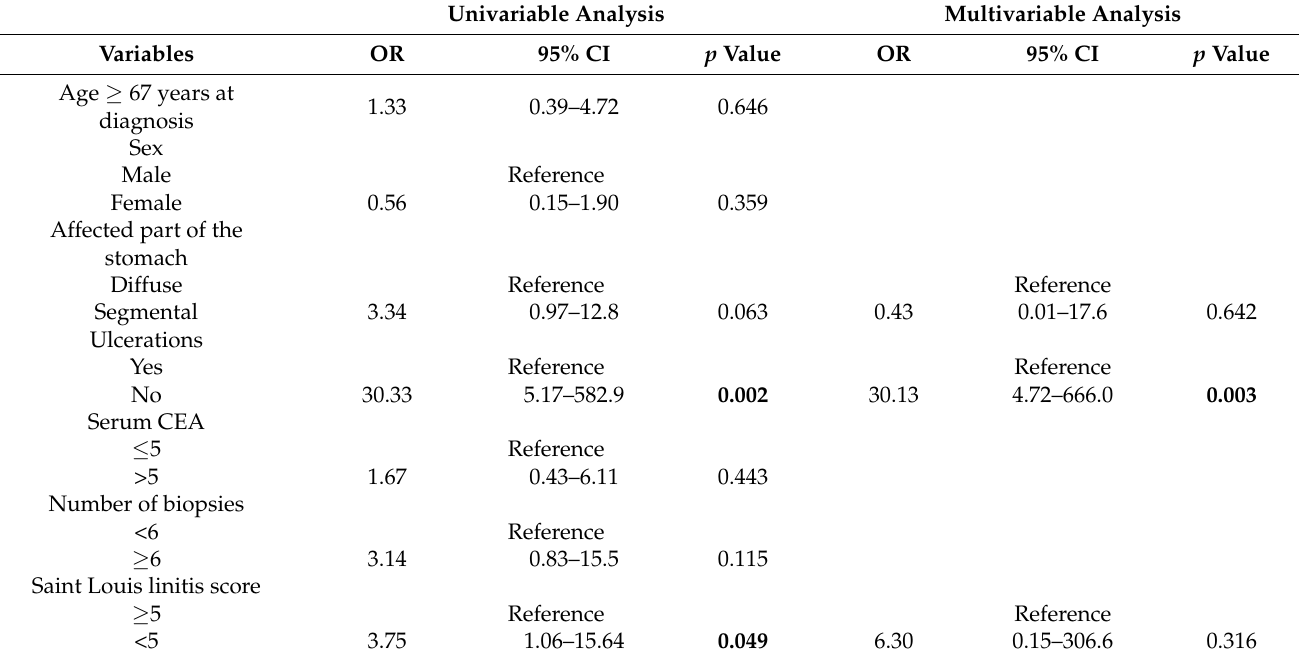
Table 3. Univariable and multivariable analyses of factors associated with negative endoscopic biopsy in patients with